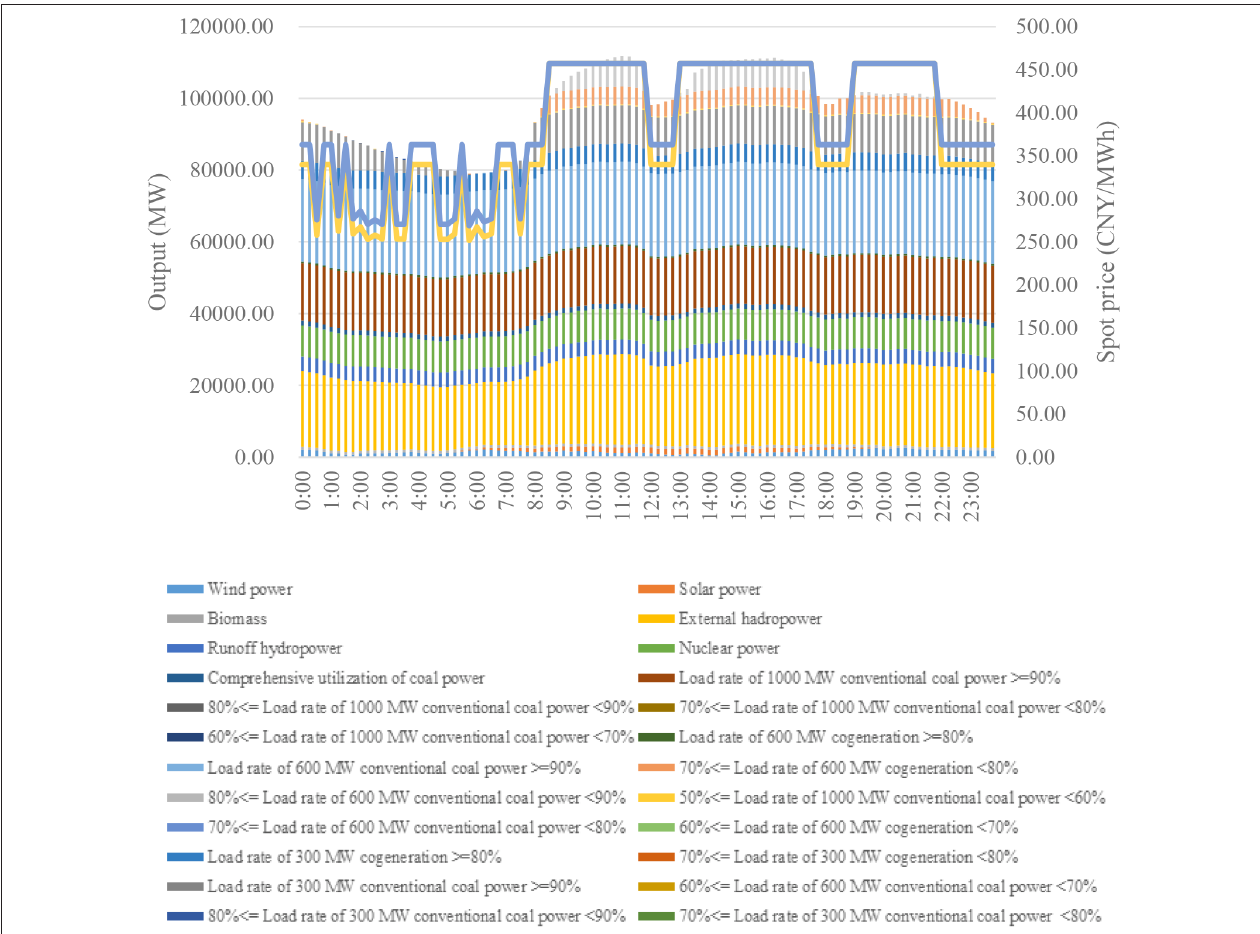
FIGURE 5 | Guangdong power supply curve and clearing electricity price in S1W1WD2L1